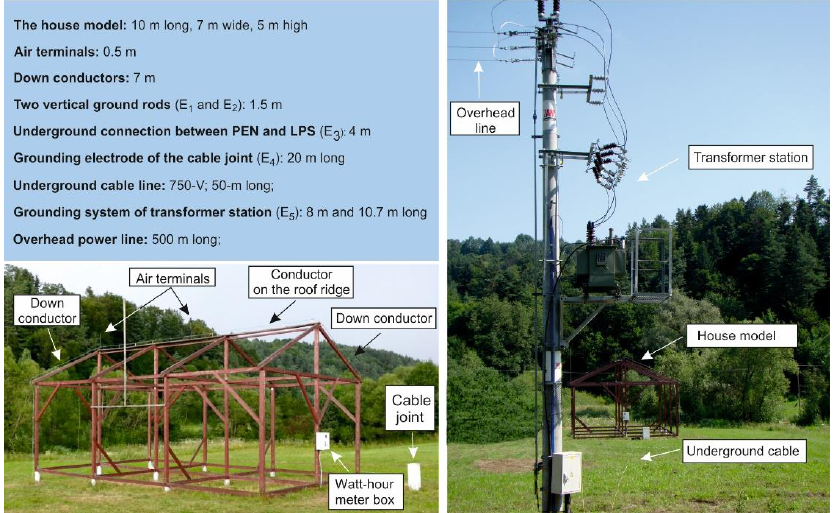
Figure 2. The test site at Huta Poreby, with the main objects and installation.